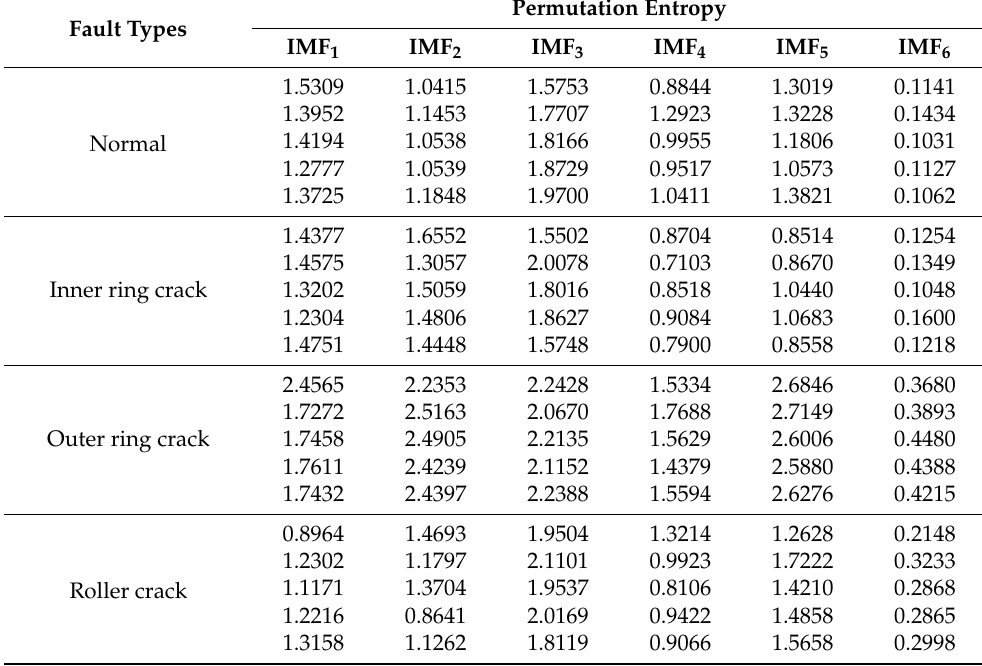
Table 6. Permutation entropy eigenvalue of vibration signal extraction.